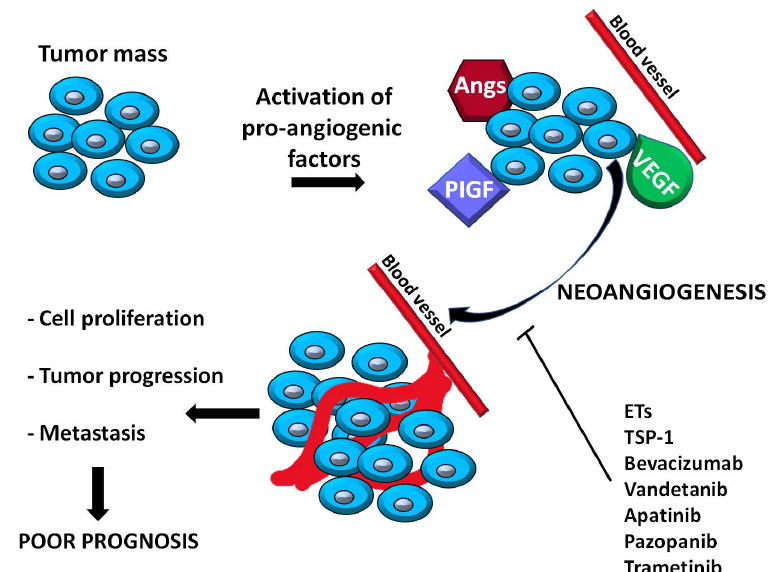
Figure 3. Neovascularization in biliary tract cancer. Cartoon shows the involvement of VEGF and other pro-angiogenic factors (PIGF and Angs) in the exacerbation of tumor-driven neoangiogenesis. New vascularization contributes to cell proliferation, tumor progression, and metastasis leading to poor prognosis. Molecules that interfere with VEGF signaling (ETs, TSP-1, apatinib, pazopanib, bavacizumab, vandetanib, and trametinib) have proved to be able to inhibit tumor